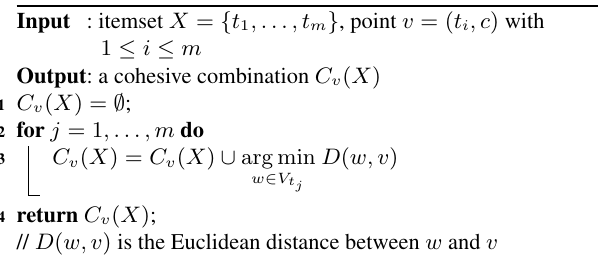
Algorithm 1: Finding a cohesive combination